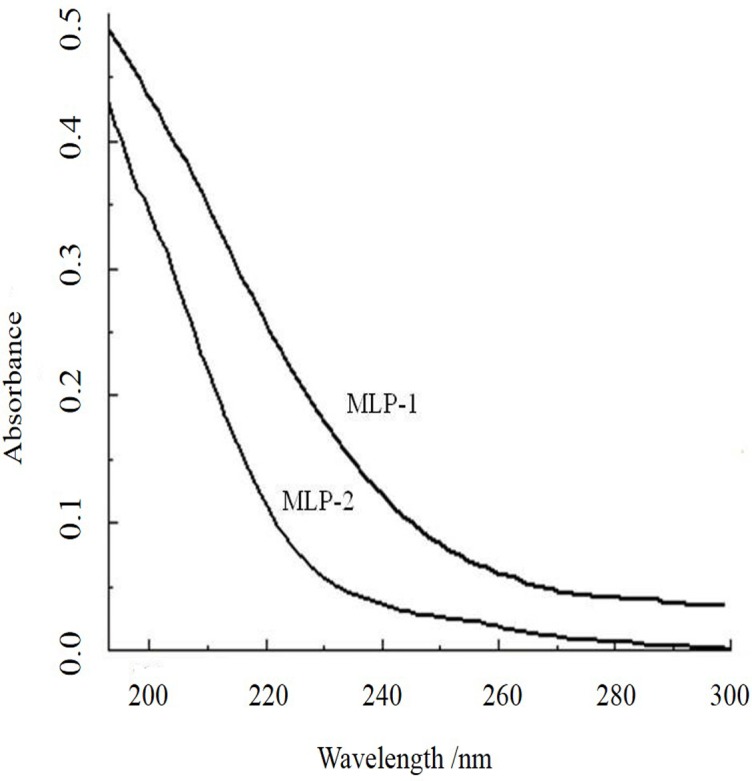
UV spectra of MLPs.